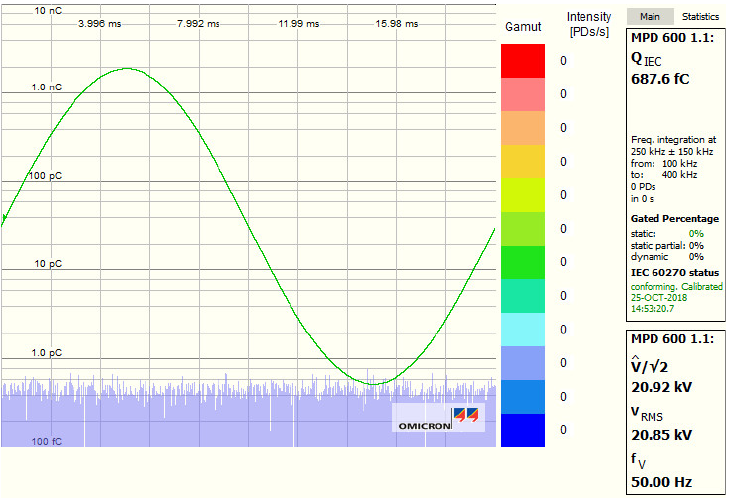
Figure 22. Testing voltage and background noise in a case of the power cable connected to the sys- tem.